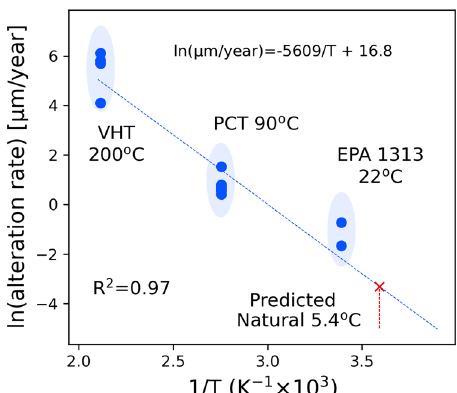
Fig. 10 An Arrhenius plot showing the natural log of the estimated alteration rate (µm yr − 1 ) as a function of the inverse temperature (K − 1 ). The linear relationship between the tests suggests that the rate-controlling mechanisms of corrosion might be similar in the different